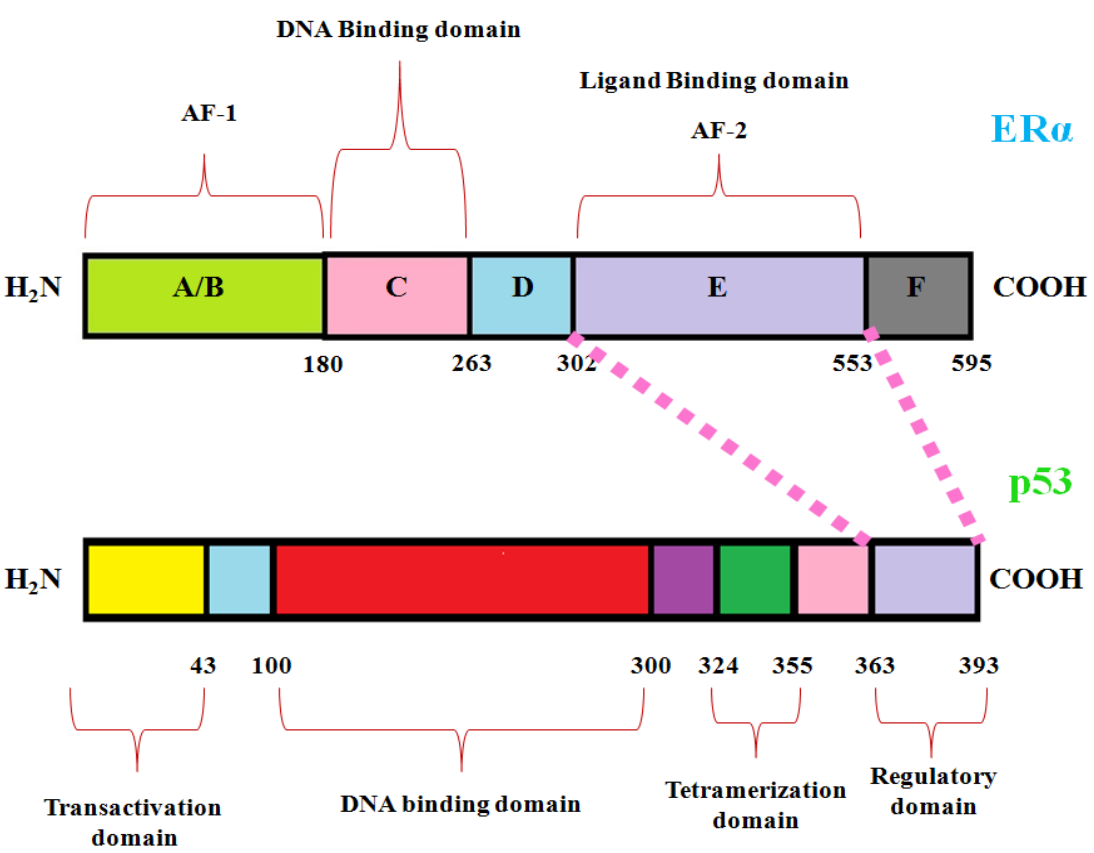
Figure 1. Schematic representation of interaction between ER α and p53. Region important for ER α –p53 interaction is shown in pink colour dotted lines. ER α domain regions were shown in the top and p53 domain regions were shown at the bottom. AF1 refers to constitutive transcription activation 1 domain and AF2 refers to the transcription-activating function 2.